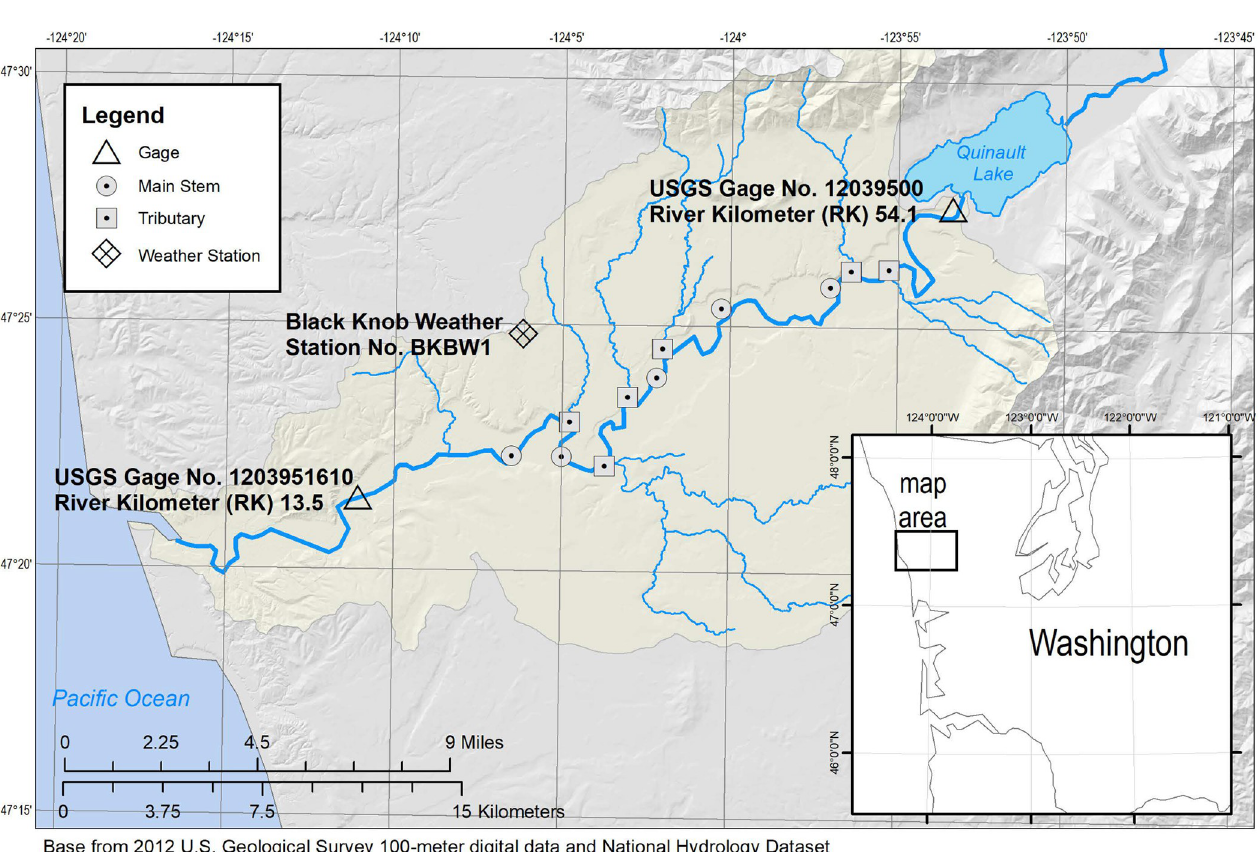
Fig 1. Map of temperature monitoring locations throughout the modeled reach of the Quinault River, Washington. Temperature loggers were deployed at each location, either on the main stem or on tributaries flowing into the Quinault River.